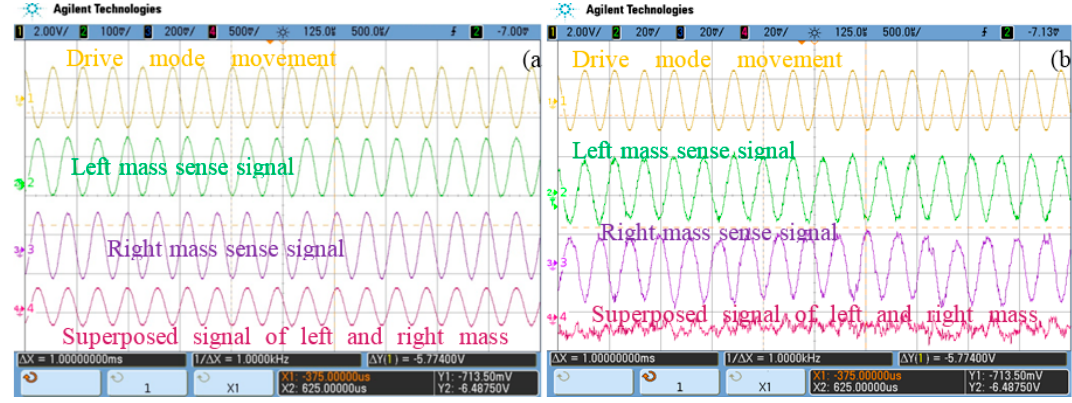
Figure 4. ( a ) Test signals before quadrature error correction; ( b ) Test signals after quadrature error using the correction method with the two masses together.